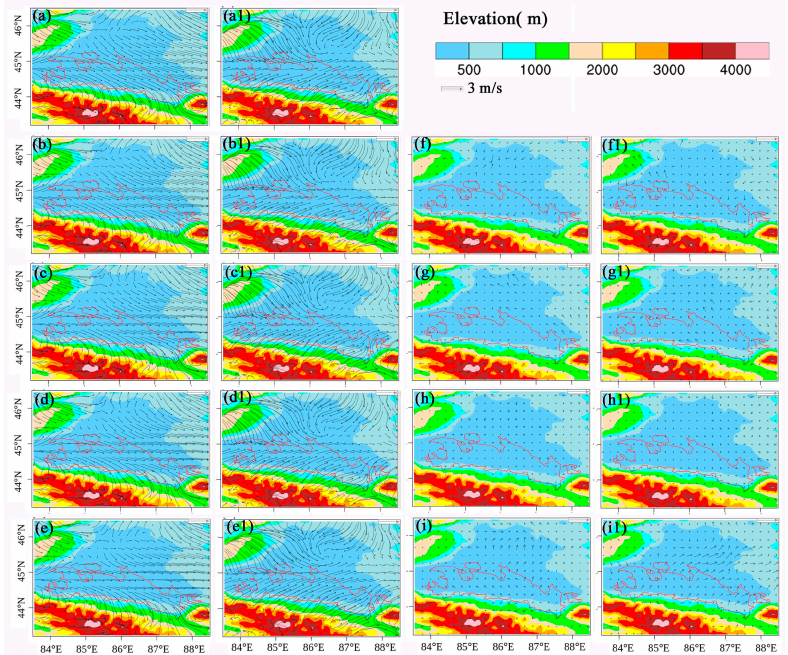
Figure 11. Daytime spatial patterns of 10 m wind speed (WS) and wind direction (WD) from the ( a ) def, ( b ) LU, ( c ) Alb, ( d ) LAI and ( e ) VF simulations, and their differences ( f ) b – a , ( g ) c – b , ( h ) d – c and ( i ) e – d (these difference pixels are statistically significant at p < 0.05). And corresponding patterns during the night-time, which are labelled with the corresponding daytime label and the number 1. The def simulation used default LU, albedo, LAI, and VF provided by WRF itself; the LU simulation used only actual LU data; the Alb simulation used only actual LU and albedo data; the LAI simulation used actual LU, albedo, and LAI data, and the VF simulation used all of the actual terrestrial datasets. The red line represents the border of the key oasis